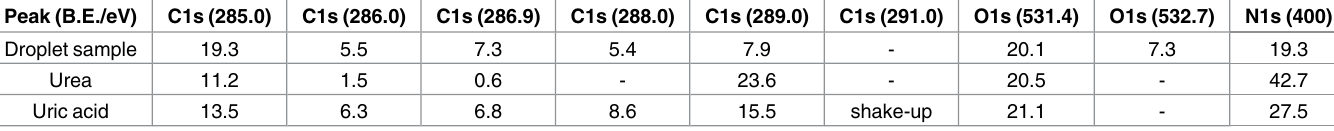
Table 5. Surface concentrations, given in atomic% and binding energies (B.E.) of peaks given in eV, as related to XPS signal contributions obtained by fitting C1s and O1s XPS spectraobtained for dry fishing lines, and for urea and uric acid powders. Peak